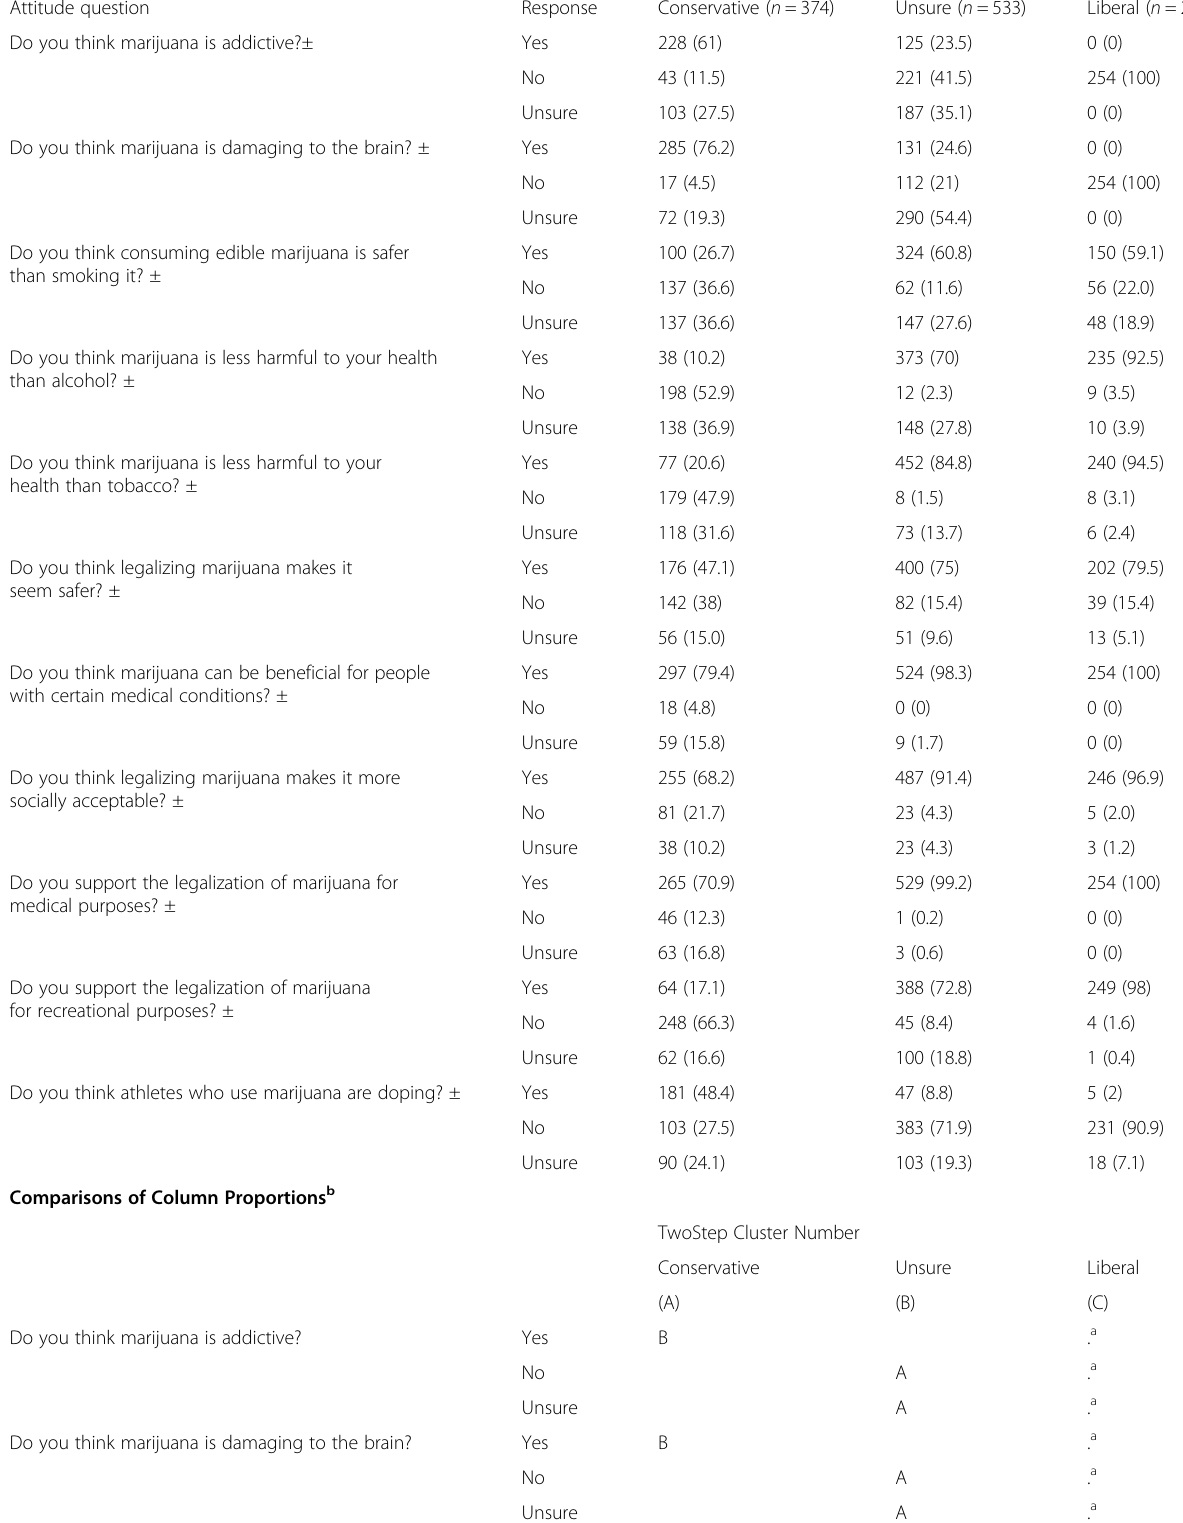
Table 2 Attitudes toward cannabis in adult athletes by cluster membership. [Data as N (%)] Attitude